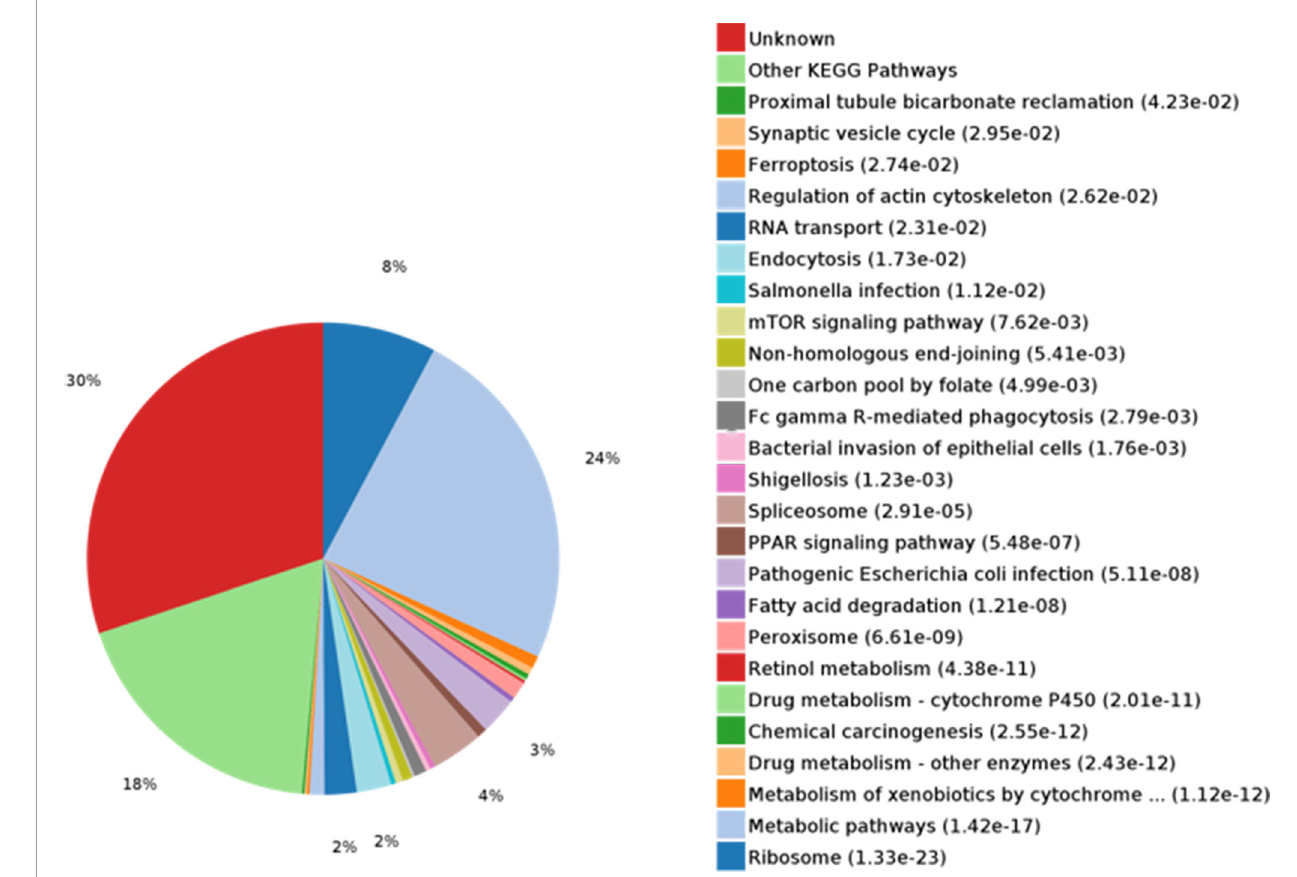
FIGURE 3 | KEGG pathway analysis and enrichment of differentially expressed proteins (DEPs). KEGG metabolic pathway analysis showed that the metabolic pathways were rich in proteins